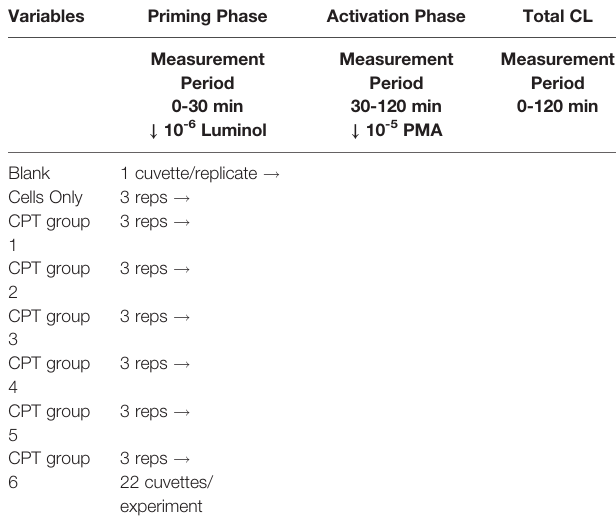
TABLE 2 | Relationship between surface roughness and contact angle on grade 2 commercially pure titanium using distilled water. Titanium Group